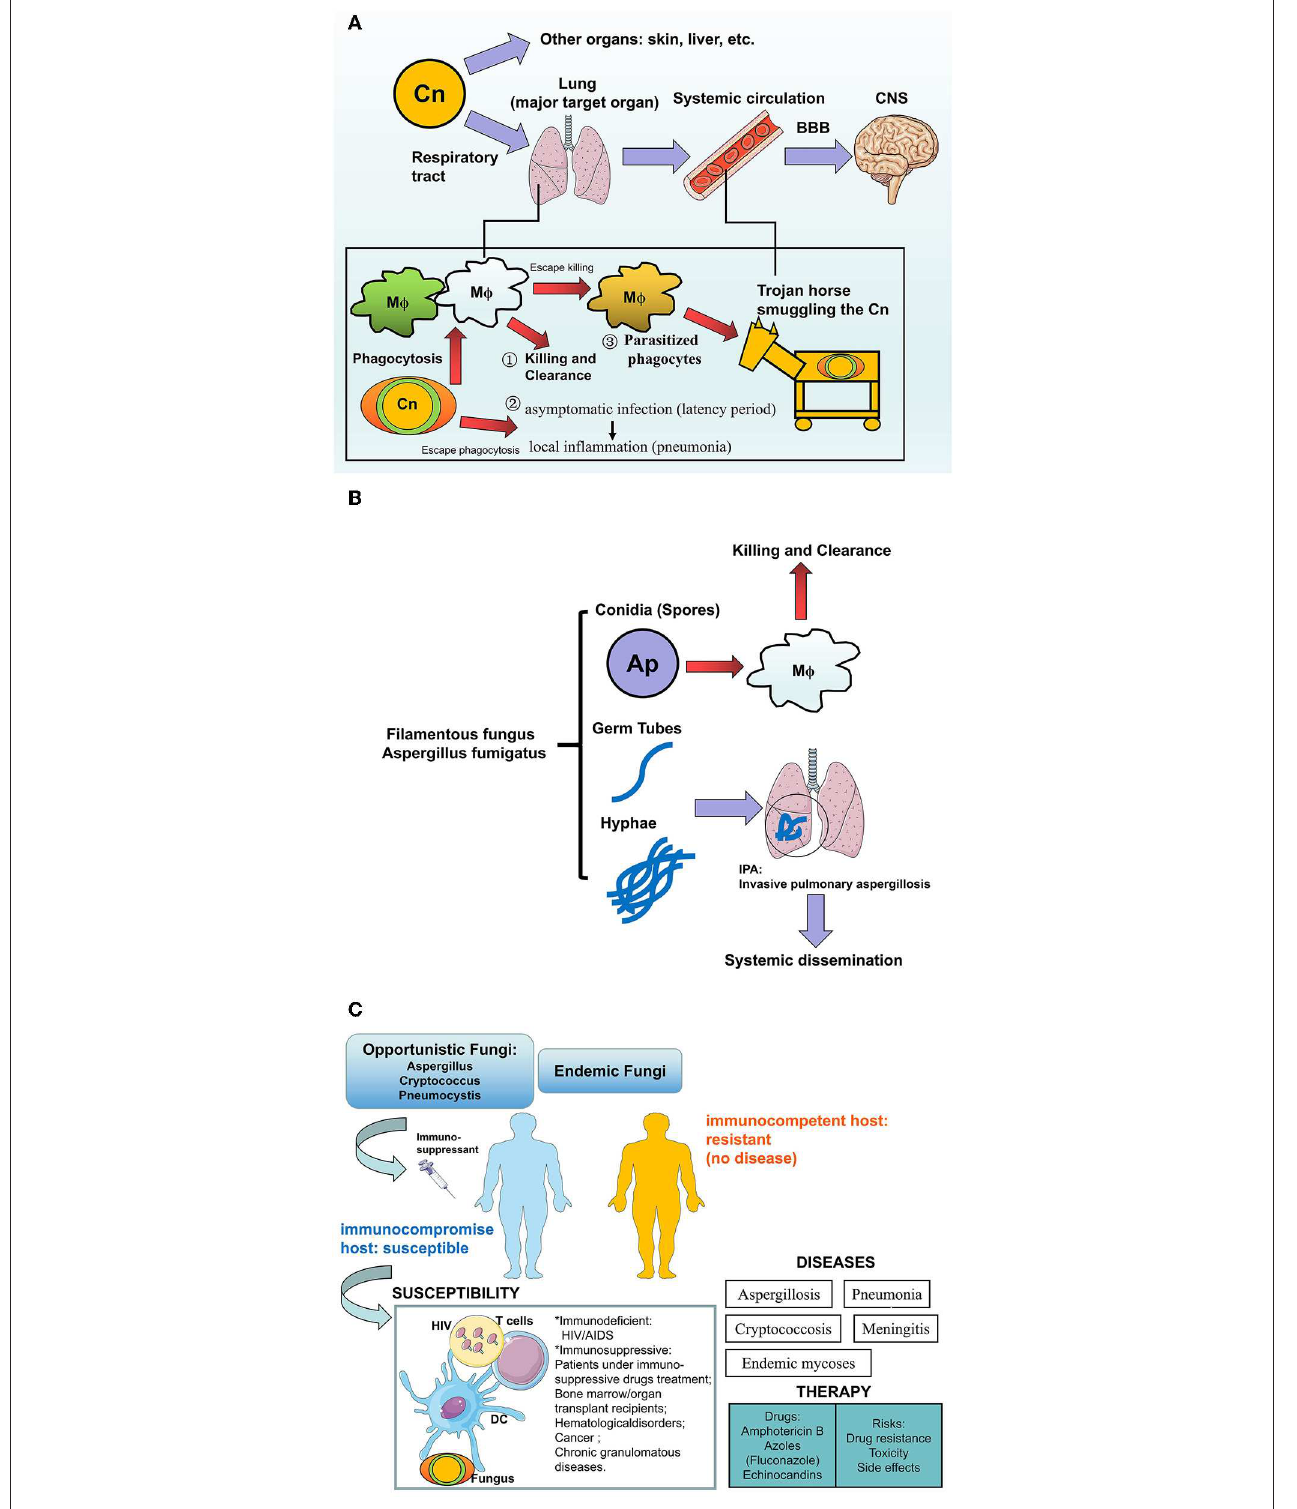
FIGURE 2 | The human fungal infections in the lung. (A) Cryptococcus neoformans infection in human: how the pathogens invade into the brains? Cryptococcus neoformans (Cn) is more aggressive to the lung via respiratory the tract compared with other organs (skin, liver, etc.), where outcomes of fungi-host communication